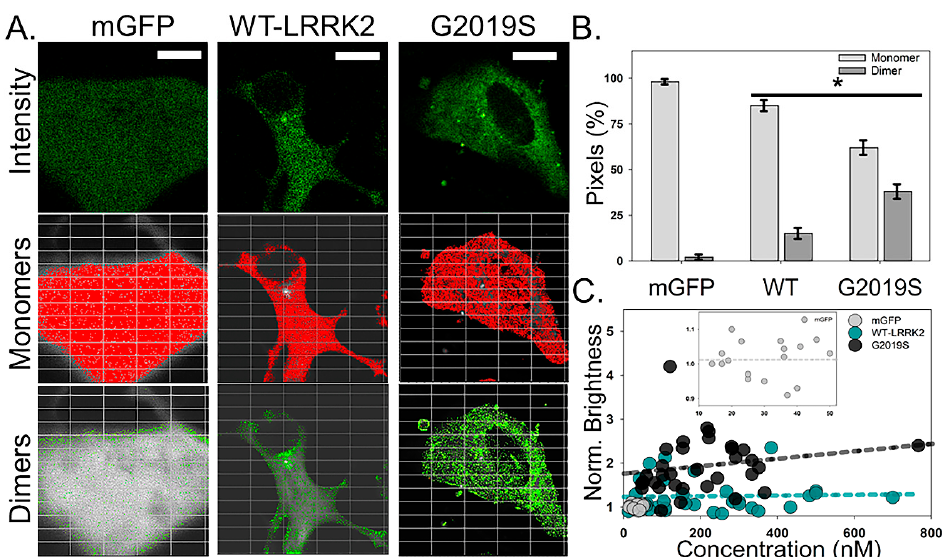
Figure 1. G2019S LRRK2 ‐ GFP has increased self ‐ association within the cell body. ( a ) Average intensity images of mGFP, WT LRRK2 ‐ GFP, and G2019S LRRK2 ‐ GFP collected using two ‐ photon (2P) confocal N&B conditions. Scale bar is 20 μ m. Overlay of pixels associated with monomers (red) and dimers (green) onto the corresponding representative intensity images. ( b ) Average pixel percentage of monomers and dimers for mGFP, WT, and G2019S. Statistical analysis was performed using a two ‐ sample t ‐ test ( p < 0.05). Error bars represent the S.E.M. n ≥ 20 cells. ( c ). The oligomeric state of WT (dark cyan) and G2019S (black) within the cytosol as a function of concentration. The best ‐ fit line for each construct is highlighted on the graph as a dashed line. The control condition, mGFP (light gray dash), is highlighted within the inset for visual comparison to our monomeric standard. Table 1. Confocal fluctuation analysis of cytosolic LRRK2 ‐ GFP constructs. Protein a Concentration (nM)